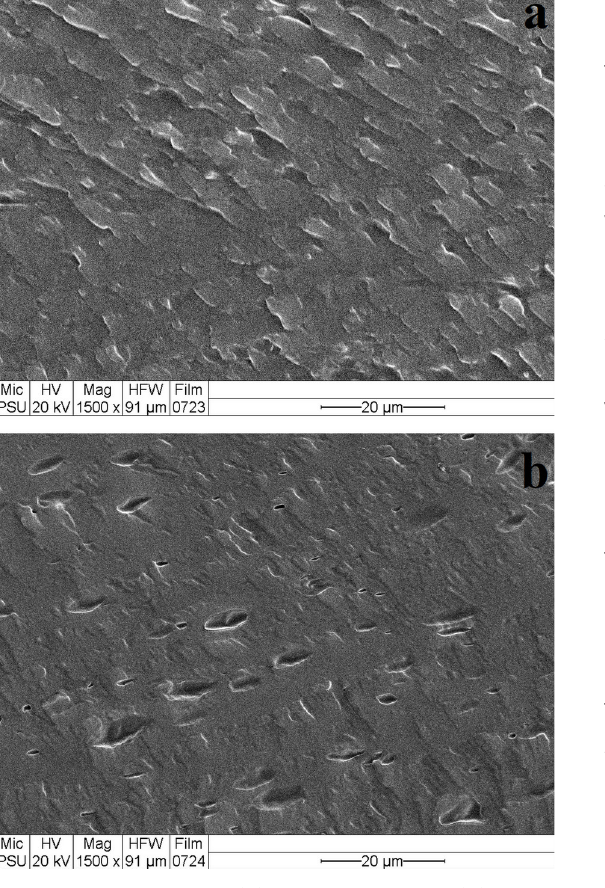
Figure 4. SEM images of (a) a blank patch and (b) a lidocaine/aspirin ionic liquid-loaded transdermal